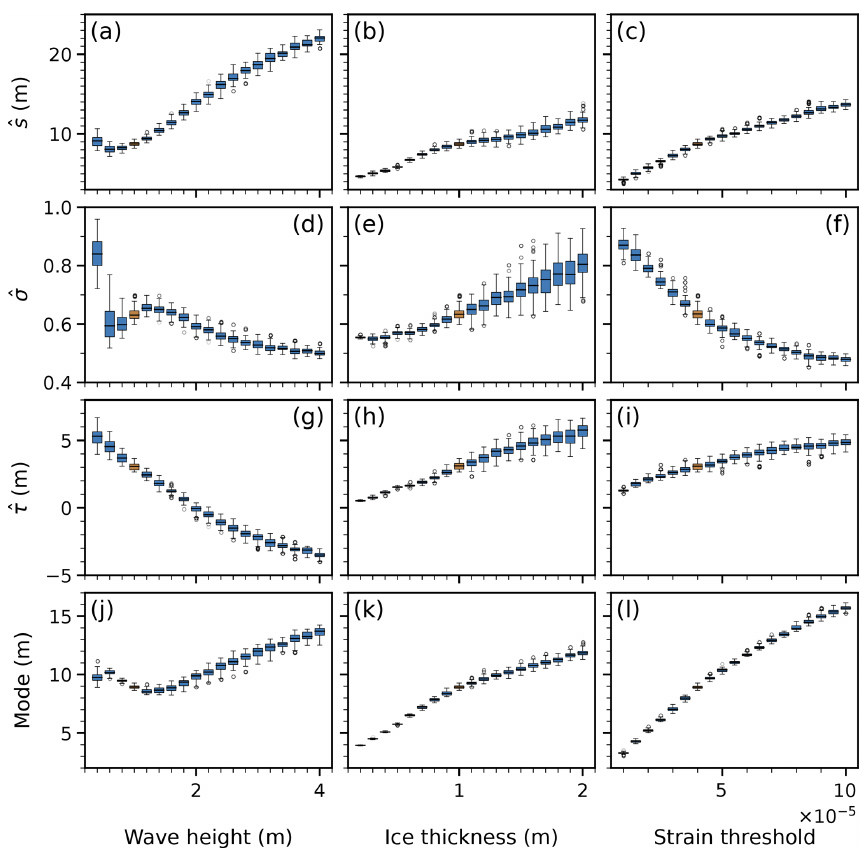
Figure 7. (a–i) Box-and-whisker plots of the estimated lognormal parameters for different model configurations. (j–l) Box-and-whisker plots of the modal floe size derived from the estimated parameters (Eq. 27). The plots show the variation across 500 realisations. The reference configuration is highlighted with a contrasting colour, where the size of the boxes